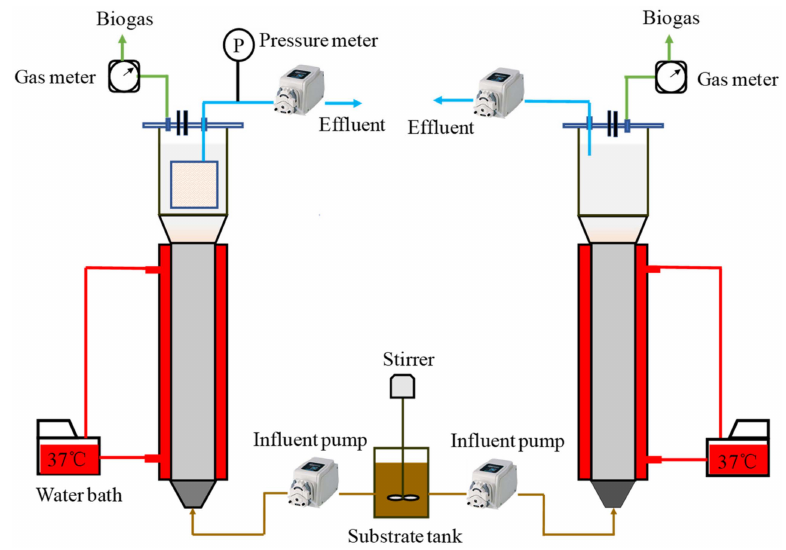
Figure 1. Schematic diagram of the AnMBR ( left ) and UASB ( right ) used in the present